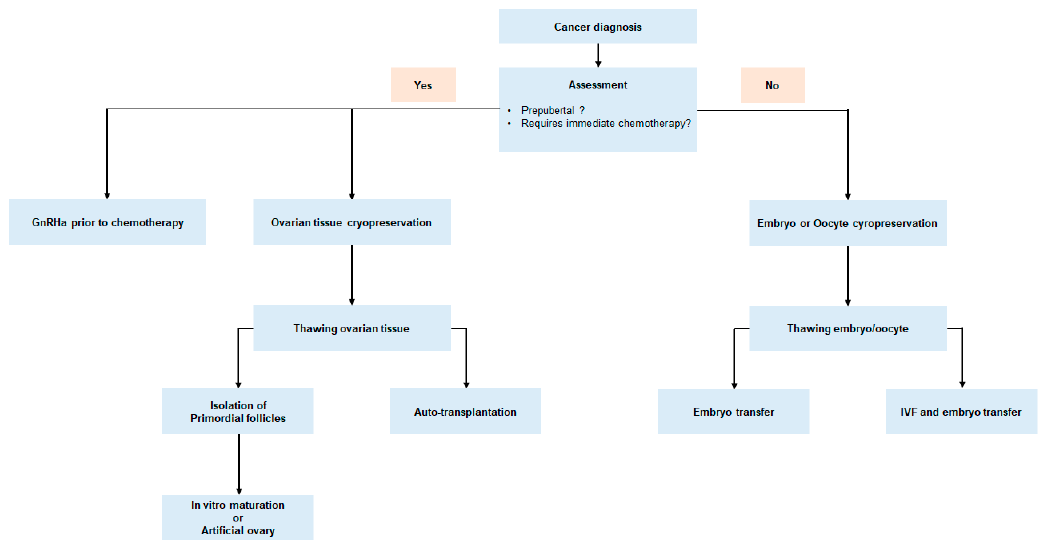
Figure 2. Fertility preservation approach for women with newly diagnosed malignancy.